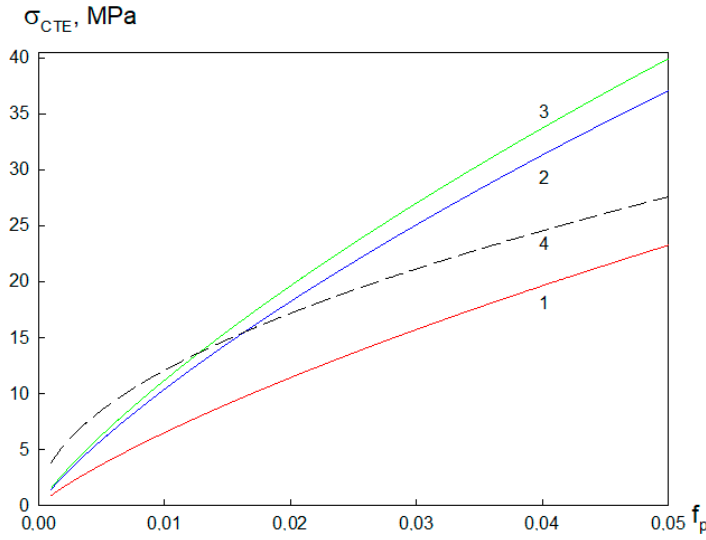
Figure 11. Dependence of thermal stresses σ CTE in the A356 alloy on the volume fraction of hardening particles; particle size δ p = 80 nm, ∆ T = 100 K. Curves 1–3 correspond to the calculation using Equation (25), while curve 4 corresponds to the calculation using Equation (7): 1—ScF 3 ; 2 —TiO 2 ; 3—Al 2 O 3 .